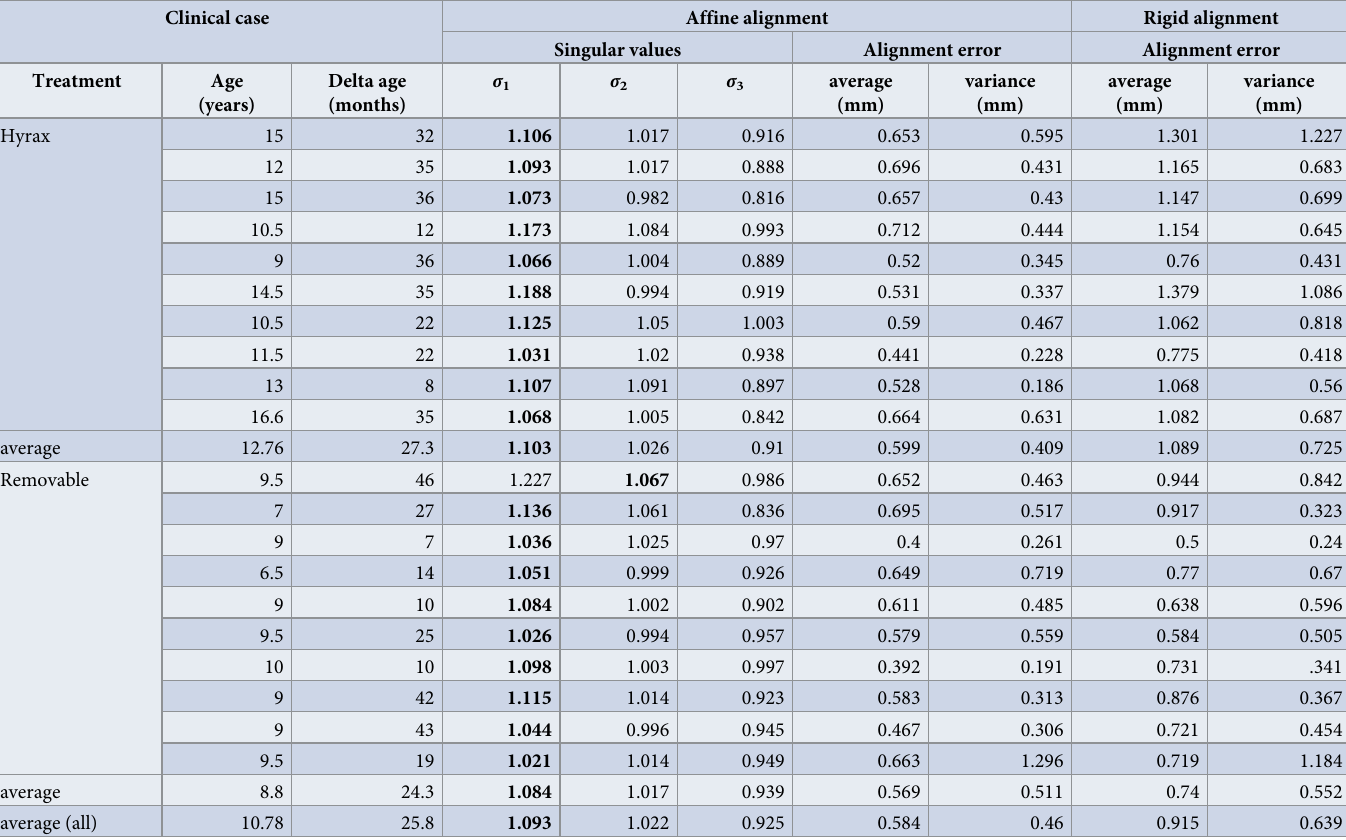
Table 1. Experimental results with several patients. Clinical case Affine alignment Rigid